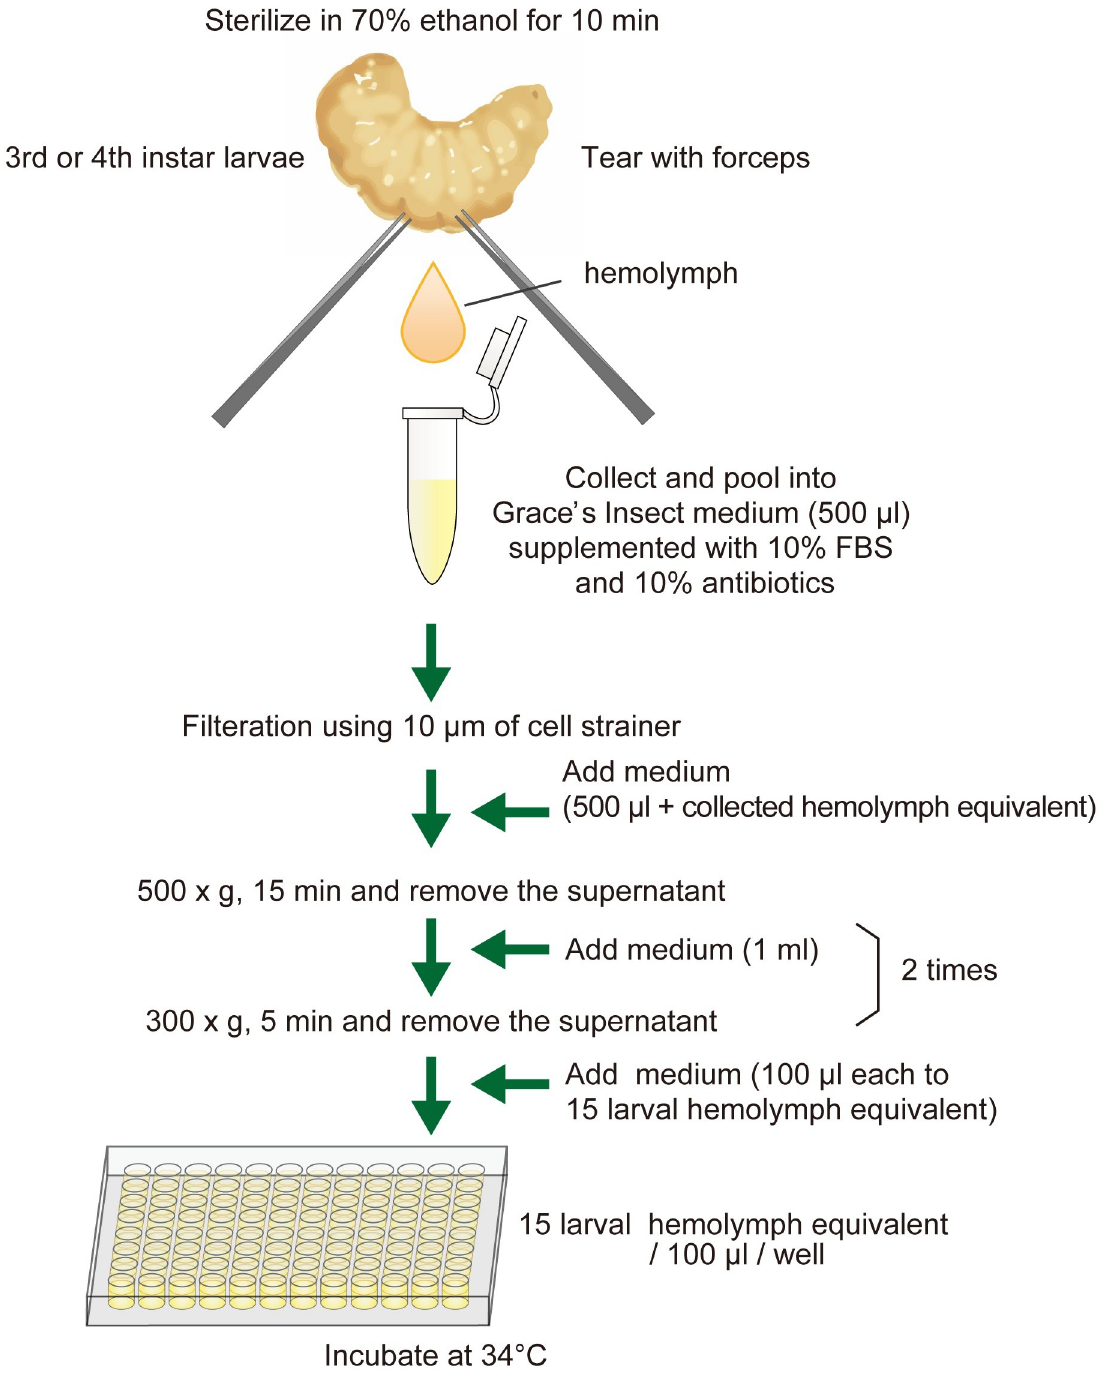
Fig 1. Method for culturing hemocyte